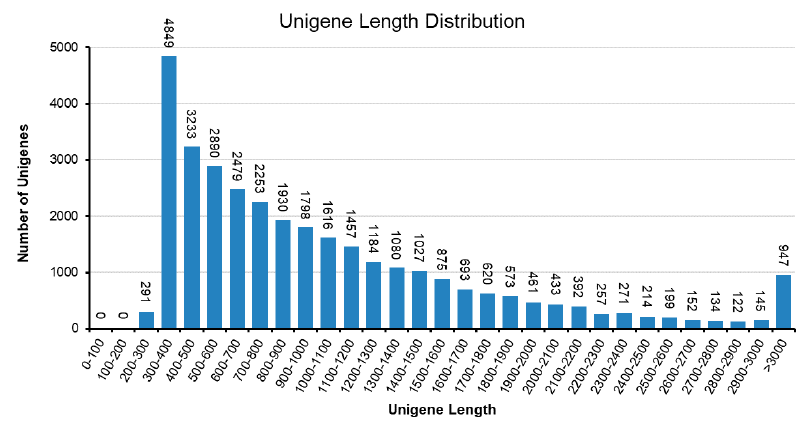
Figure 2. Sequence length distribution of the unigenes in D. bigibbum transcriptomes . The x -axis indicates unigene length intervals from 200 bp to >3000 bp. The y -axis indicates the number of unigenes of each given length.